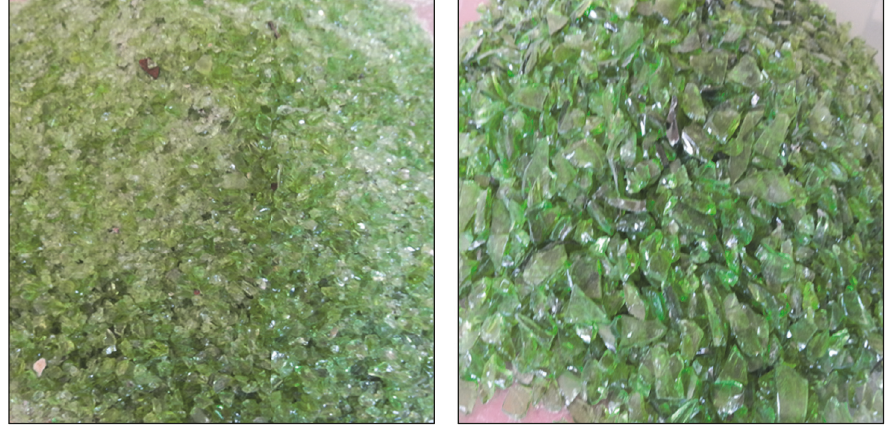
Figure 1: Fine and coarse grade of WG cullet.